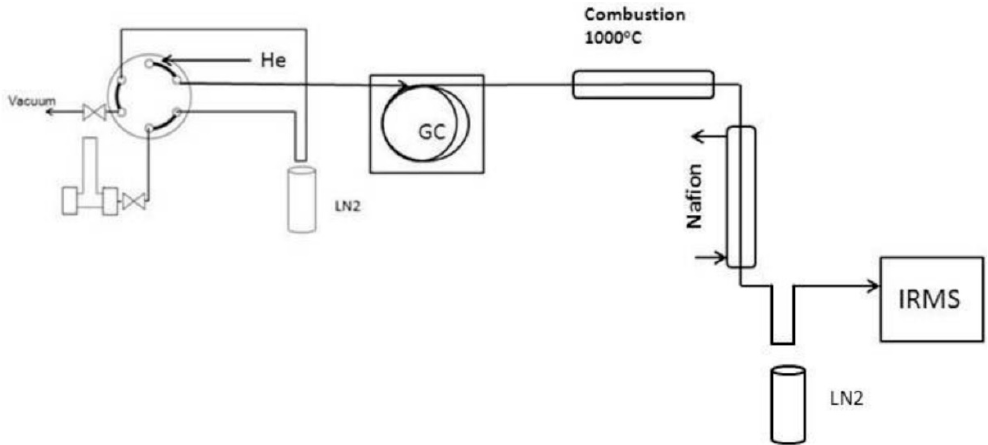
Figure 2. Hydrocarbon combustion line. The sample loop is evacuated and connected to the hammer mill, and part of the mill content is transferred to the loop. The gas from the loop is injected into the gas chromatograph. The loop can be immersed in liquid nitrogen to concentrate higher hydrocarbons. Hydrocarbons are separated inside Trace GC.